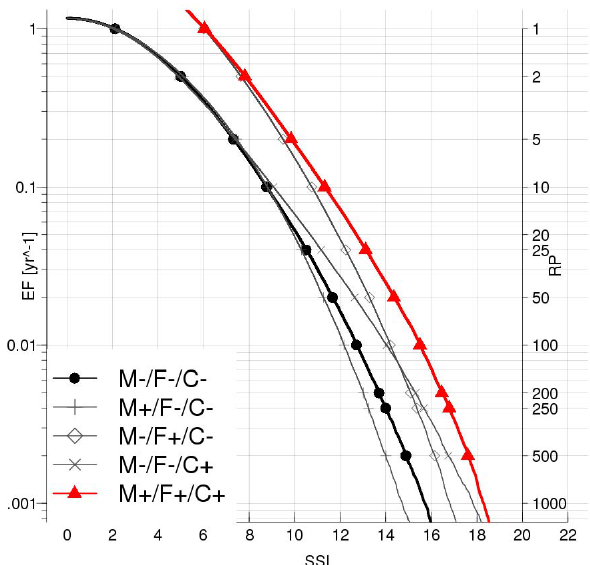
Fig. 9. M(arginal), F(requency) and C(opula) contribution to south- UK + west-DK SSI EEF changes due to NAO phase (+ positive/ − negative). M+/F+/C+ and M − /F − /C − have been fitted to data and are identical to red lines in panel b and c of Fig. 8, while M − /F+/C+, M+/F − /C+ and M − /F − /C+ are synthetic Copulas constructed us- ing NAO − components except one. Frequency distribution is the single most important driver of SSI EEF change going from NAO − to NAO+ up to RP 200yr. For longer RPs the increase of tail de- pendence observed during positive NAO phase plays a comparable